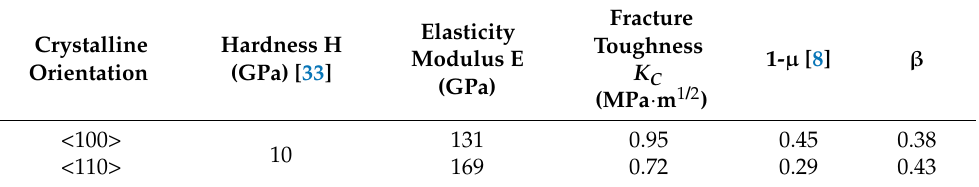
Table 3. The properties of the mono-crystalline silicon (N type, top surface is oriented in the (100)